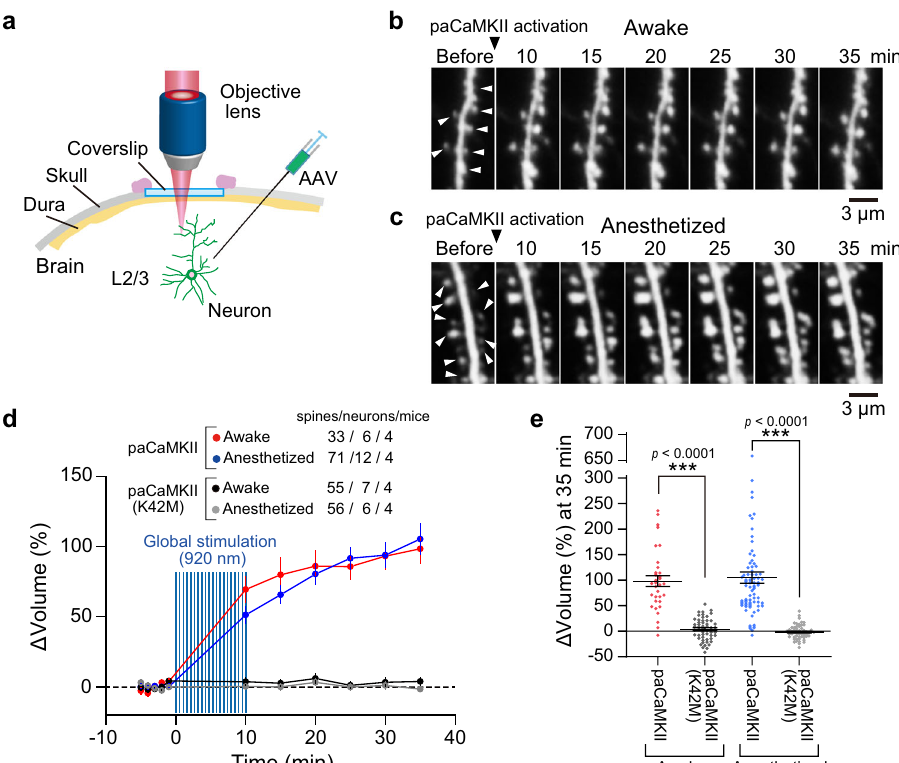
Fig. 8 paCaMKII activation triggers sLTP in cortical neurons in vivo. a Schematic drawing of in vivo imaging. Using a DIO system in combination with a low expression of Cre, Clover was sparsely expressed in neurons and was excited by two-photon excitation at 1000nm. b , c Two-photon images of dendritic spines of layer 2/3 pyramidal neurons of the sensory cortex. The paCaMKII was activated by global scanning with two-photon excitation at 920 nm. The images were taken in awake ( b ) and anesthetized ( c ) states. White arrows indicate the enlarged spines by paCaMKII activation. d Averaged time courses of spine volume change induced by paCaMKII activation. Data using the kinase-dead paCaMKII K42M are also shown. The number of samples (spines/neurons/mice) is indicated in the fi gure. The data are presented as mean ± SEM. e Quanti fi cation of spine volume change at 35 min after paCaMKII activation. The same data set with ( d ) was used. n (spines/neurons) is the same as in d . The data are presented as mean ± SEM. *** p < 0.001; two-tailed unpaired t test. Source data are provided as a Source Data fi